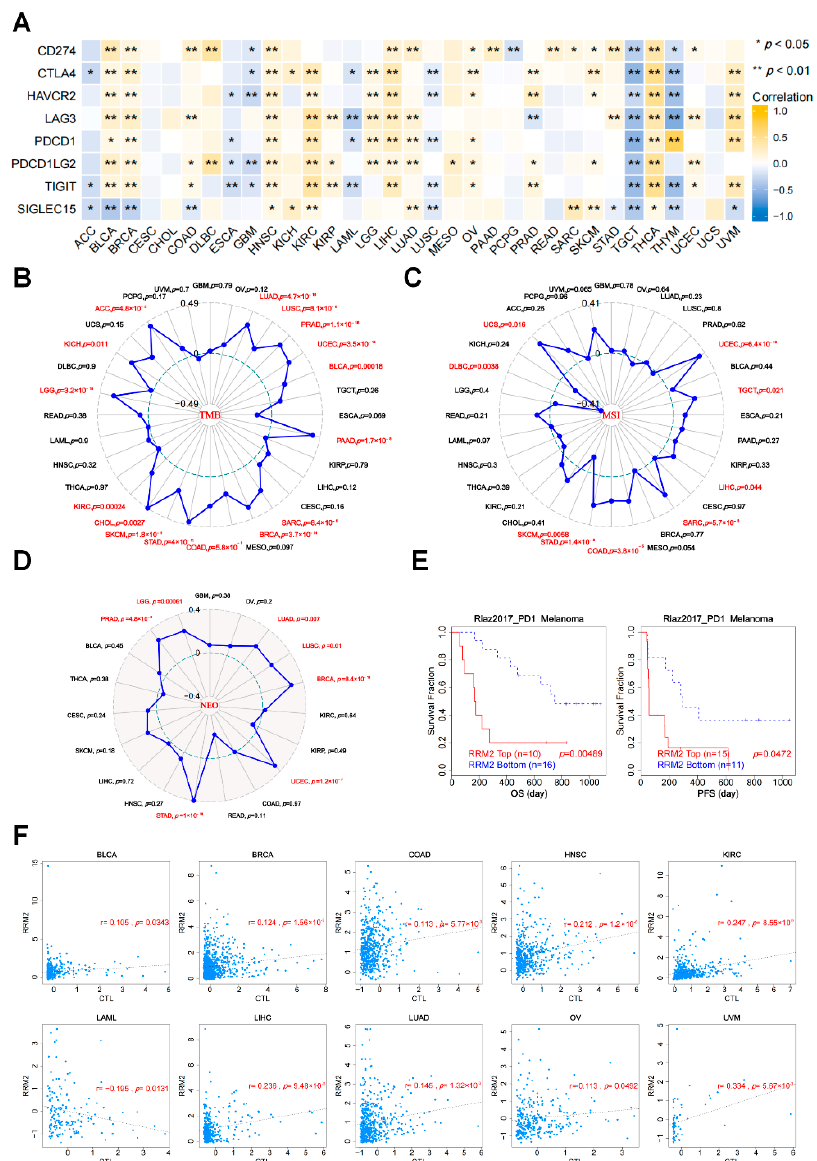
Figure 8. Correlation between RRM2 and immunotherapy. ( A ) Correlation of RRM2 expression with immune checkpoints. ( B − D ) Correlation of RRM2 expression with TMB ( B ), MSI ( C ) and NEO ( D ) (Red color indicated statistical significance). ( E ) Kaplan-Meier curves of survival ratios as a measure of the PD1 immunotherapeutic response between high and low expression of RRM2 in in Riza2017_PD1 clinical study of melanoma. ( F ) The correlation between the RRM2 expression and CTL in TCGA cohorts. (* p < 0.05, ** p < 0.01, red color indicated statistical